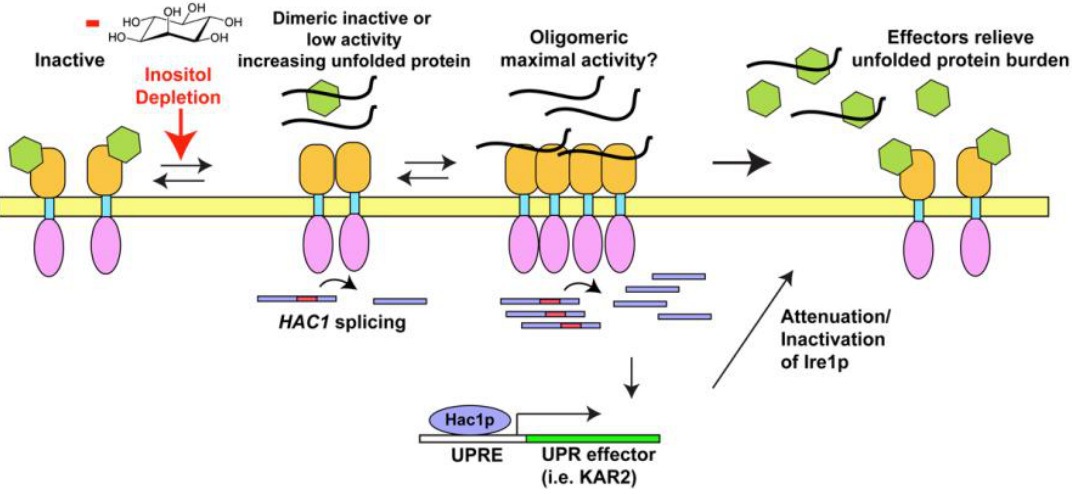
Figure 1. Illustration of Ire1p activation and inactivation. Unfolded protein accumulation and inositol depletion stimulate BiP/Kar2p release and Ire1p oligomerization. Splicing of HAC1 mRNA is further enhanced by peptide binding to Ire1p and Ire1p clustering. Increased levels of Hac1p upregulate UPR effectors leading to resolution of